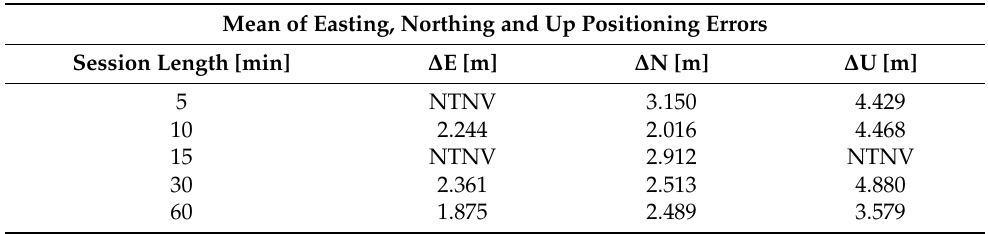
Mean of Easting, Northing and Up Positioning Errors